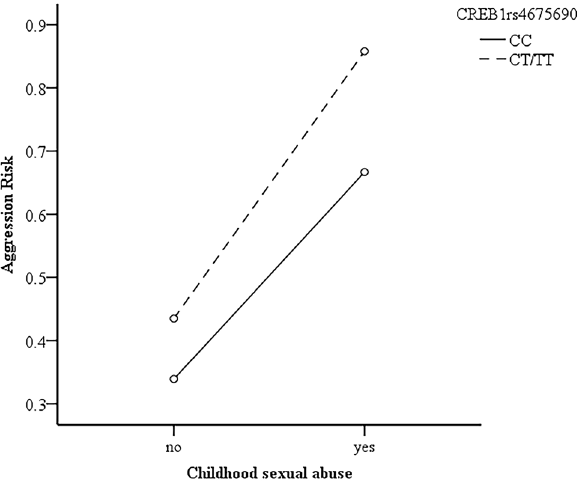
Figure 1. The interactive effect of CREB1 rs4675690 polymorphism and childhood sexual abuse on aggression risk.